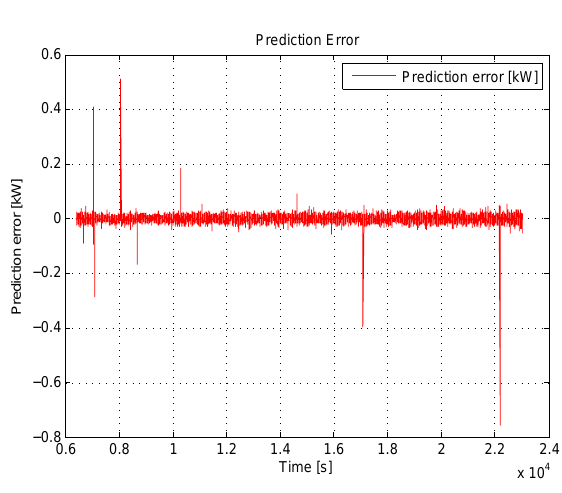
Figure 6: Residual plot after handling outliers. Figure 7: The dataset after being preprocessed. It